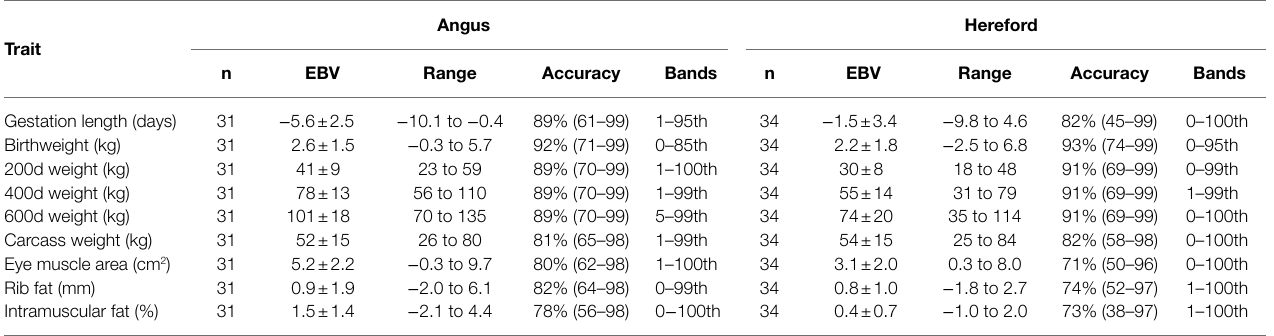
TABLE 1 | Estimated breeding values (EBV; mean ± SD), with total range, accuracy (mean and range), and percentile bands for gestation length, liveweight (at birth, 200, 400, and 600 days of age), and carcass traits (carcass weight, eye muscle area, rib fat, and intramuscular fat), for 31 Angus and 34 Hereford sires.